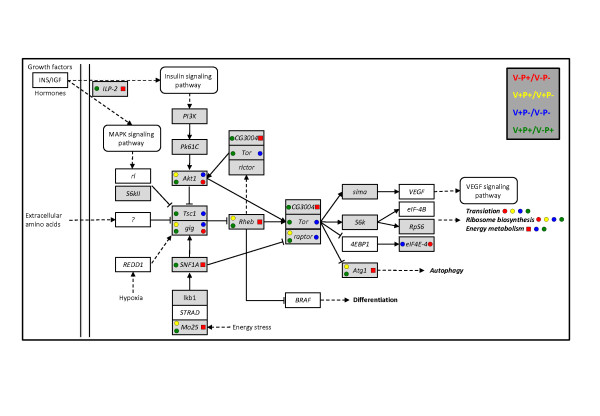
mTOR signaling pathway affected by pollen feeding or varroa parasitism. Genes from the Drosophila mTOR signaling pathway that were differentially transcribed after pollen feeding or varroa parasitism. The pathway was modified from KEGG: Kyoto Encyclopedia of Genes and Genomes http://www.kegg.com/. Grey indicates the presence of genes in the bee genome. Squares and circles indicate genes and enriched functions that were up- and downregulated between two treatments, respectively.